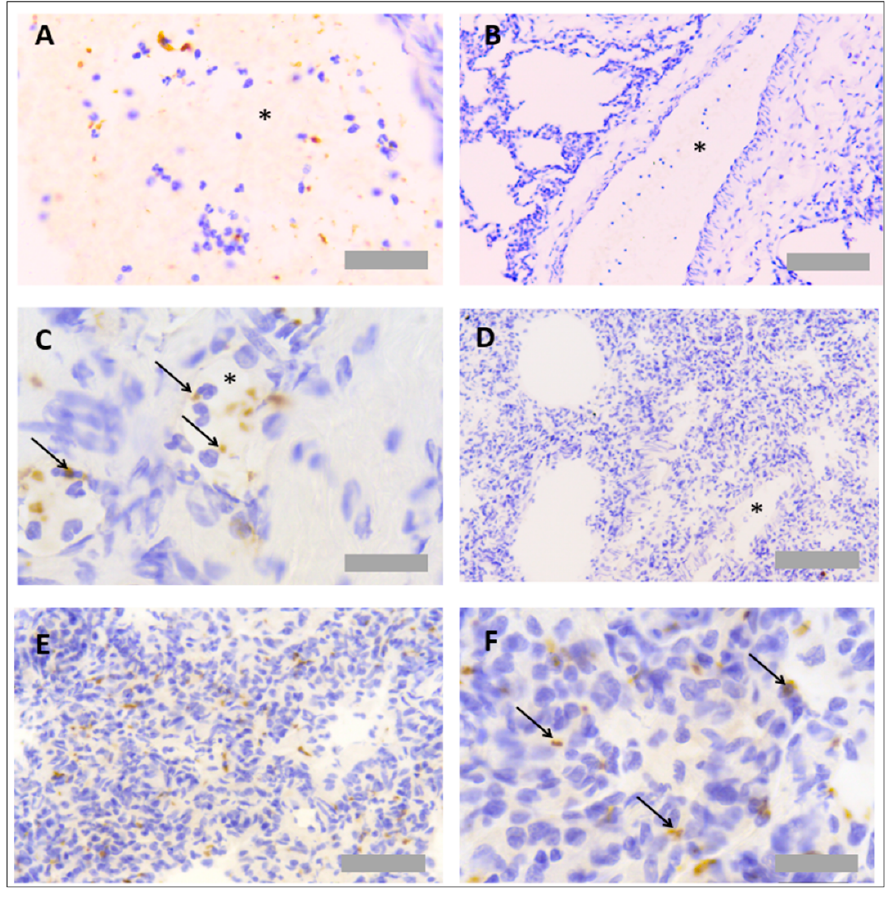
Figure 6. Platelet immunohistochemistry in frozen pig lung and liver tissues. Consecutive sec- tions were immunostained with primary antibody ( A ) and without primary antibody ( B ), to detect unspecific binding of detection reagents. Representative images of platelet immunohistochemistry (anti-CD49b) in frozen pig lung tissue ( C ) are also shown. Signal is absent in the reagent only control ( D ). Platelets were also observed in the liver tissue ( E , F ). Asterisks denote blood vessels. Arrows denote CD49+ platelet events. Scale bar = 50 μ m in Figures ( A , E ) (×40 objective), 100 μ m in Figures ( B , D ) (×20 objective) and 20 μ m in Figures ( C , F ) (×63 objective).